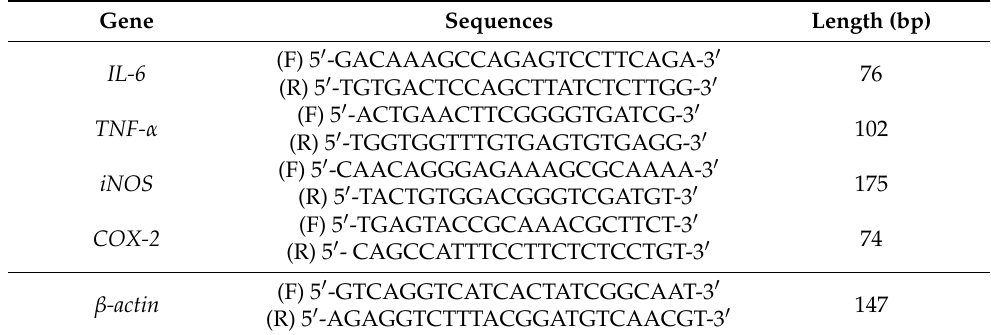
Table 1. The primer